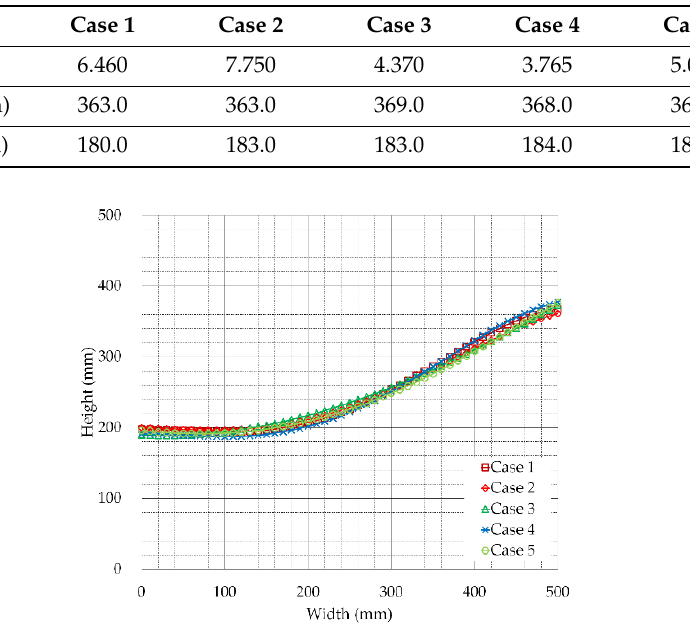
Table 4. Summary of slushing heights generated by earthquakes of different shapes.